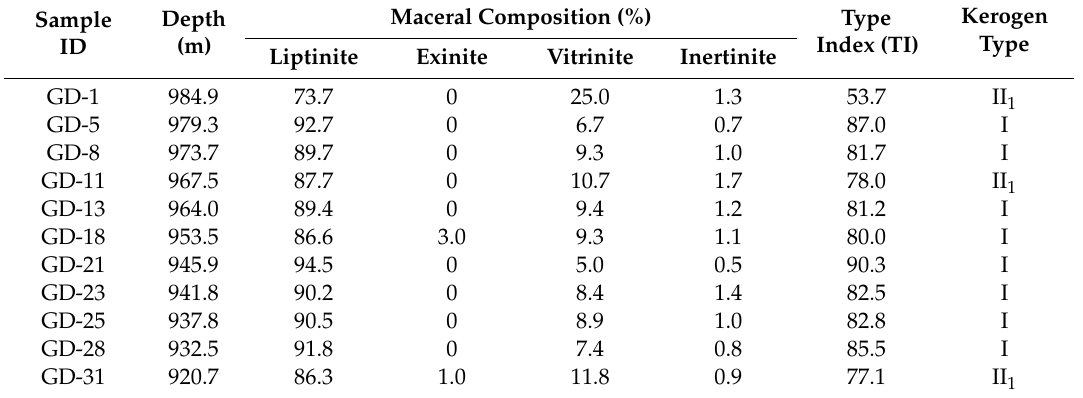
Table 1. Results of kerogen microscopic analysis of the Dalong Formation shales.